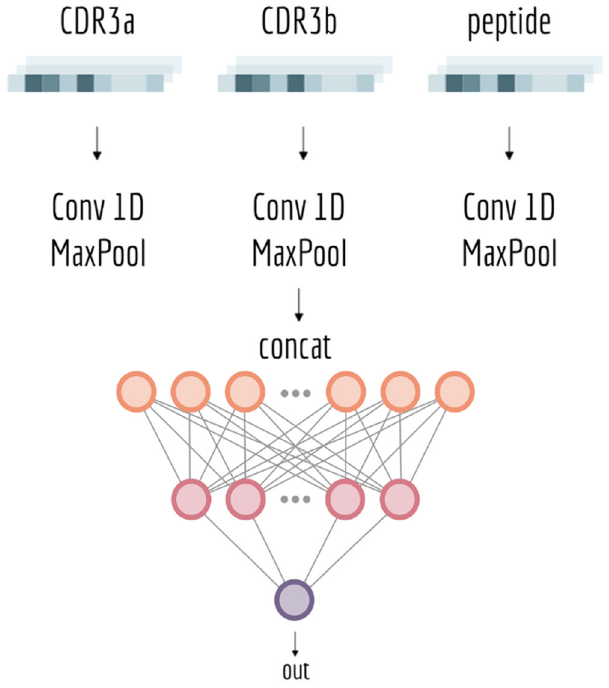
Fig. 10 Setup of NetTCR model. The CDR3 and peptide sequences are encoded using the BLOSUM50 matrix. The encoded sequences are passed independently through a 1D convolutional layer and a max-pooling layer. The convolutional fi lter size is set to {1, 3, 5, 7, 9}, and for each fi lter size, 16 fi lters are used. The extracted features are then concatenated and fed into a dense layer with 32 hidden units. The output of the network consists of a single neuron, giving the binding